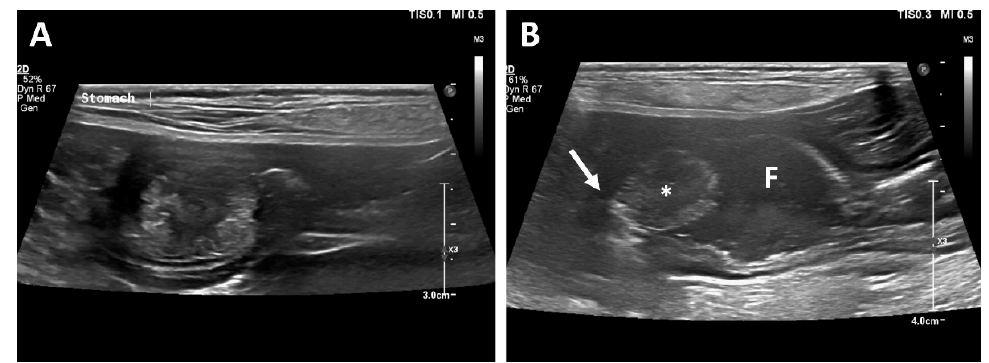
Figure 1. Longitudinal ultrasonographic examination. A mass arising from the mucosal layer was identified ( A ). A sessile echogenic lesion (asterisk) with a broad base (arrow) arising from the mucosa was identified after feeding water ( B ). Fluid (F) is present in the stomach.